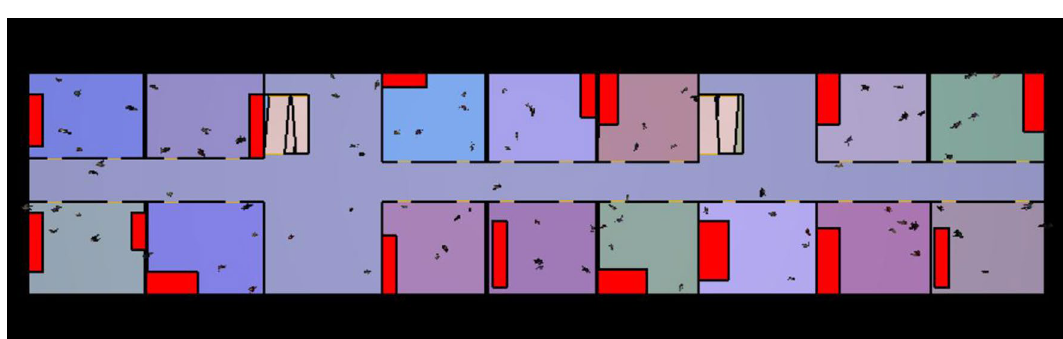
Figure 19. Optimized stacking of building